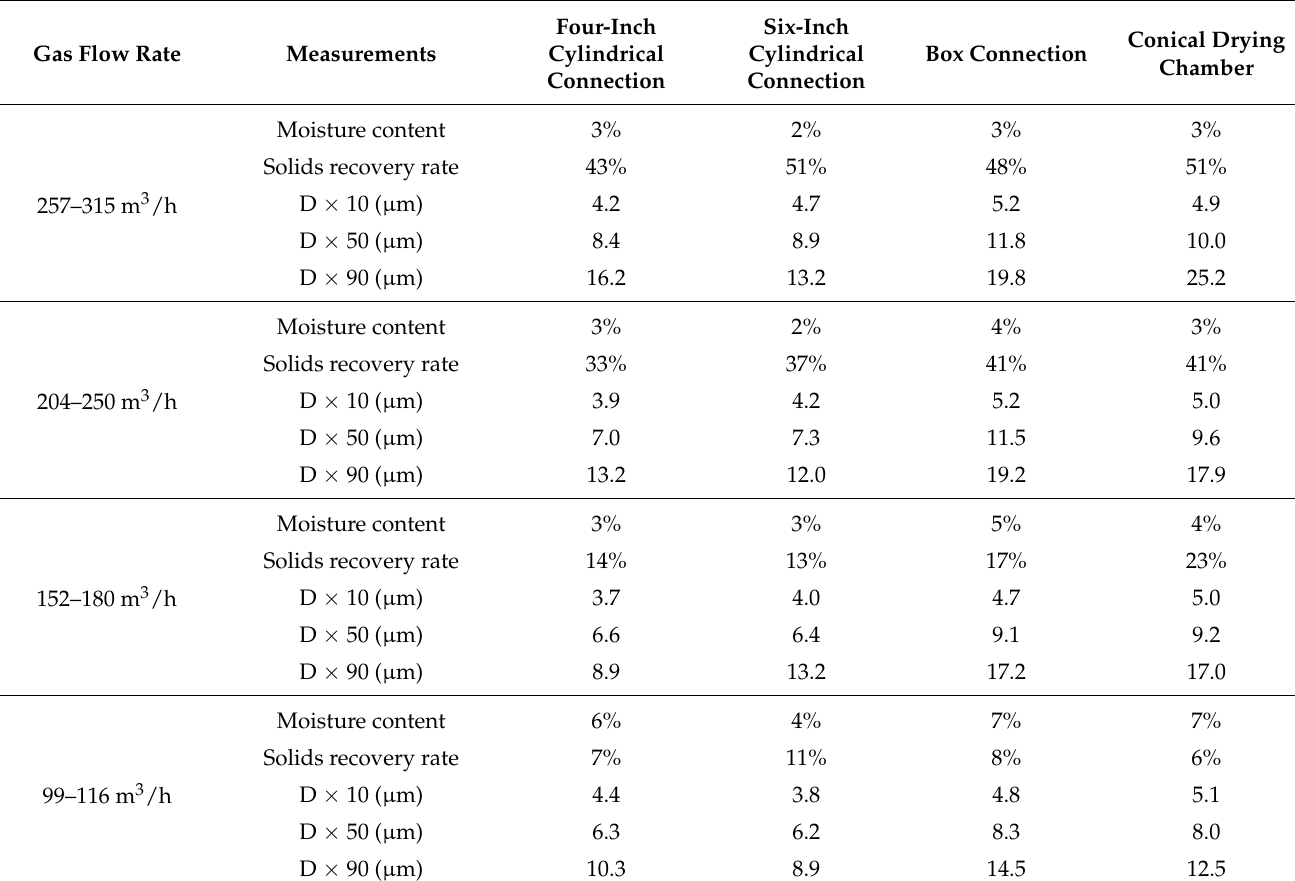
Table 5. Physical properties of spray dried powder collected from different designs and gas flow